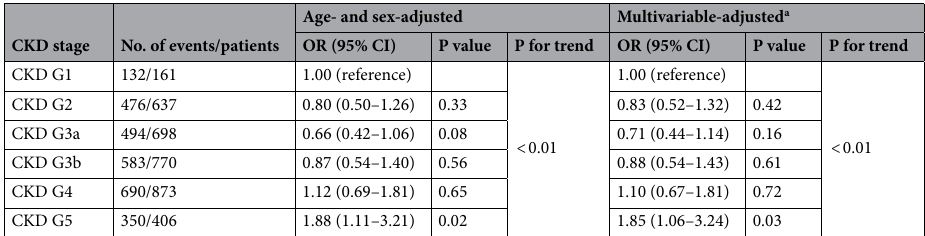
Table 5. Association between CKD stage and the prevalence of low intake of vegetables. CKD, chronic kidney disease; CI, confidence interval; OR, odds ratio; s.e., standard error. a Adjusted for age, sex, diabetes, history of cardiovascular disease, systolic blood pressure, body mass index, serum albumin concentration, low-density lipoprotein cholesterol, log-C-reactive protein, and urinary protein/creatinine